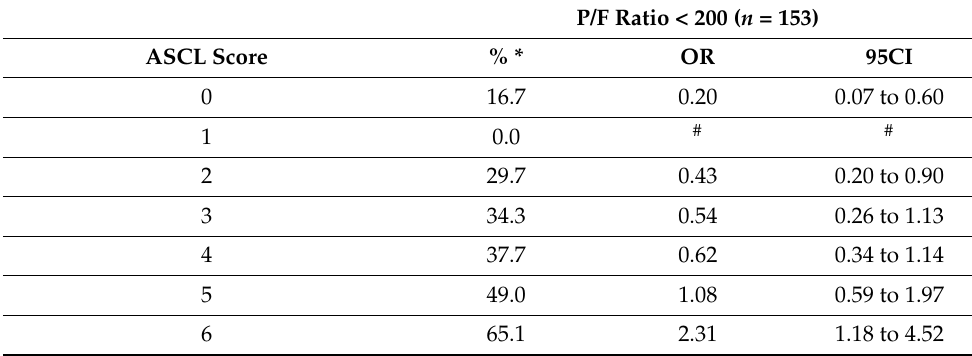
Table 6. Logistic regression analysis for P/F ratio < 200 during hospitalization according to the ASCL